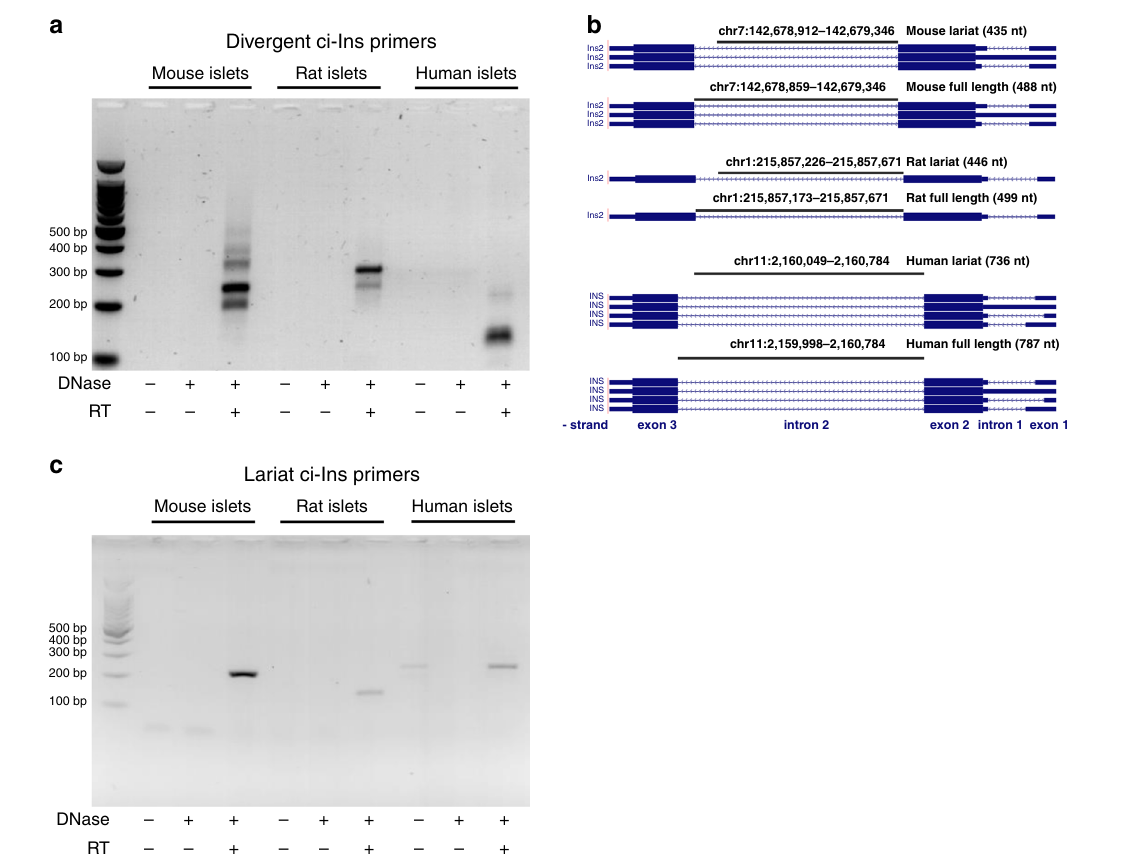
Fig. 1 Insulin circular intronic RNAs are detectable in mouse, rat, and human islets. a Agarose gel electrophoresis picture showing circRNAs ampli fi ed by qPCR using divergent primers targeting the intron 2 of mouse Ins2 , rat Ins2 , and human INS . b Loci of sequenced qPCR products of mouse Ins2 (mm10), rat Ins2 (rn6), and human INS (hg38) intron 2 lariat and full-length circRNAs. The image was obtained using the UCSC genome browser (http://genome.ucsc. edu). c Agarose gel electrophoresis picture of lariat mouse and rat ci-Ins2 and human ci-INS qPCR products ampli fi ed with over-junction primers. a , c cDNA synthesis of islet RNA was performed with ( + ) or without ( − ) DNase treatment and with ( + ) or without ( − ) addition of reverse transcriptase (RT). n = 1 independent experiment. Source data are provided as a Source Data fi